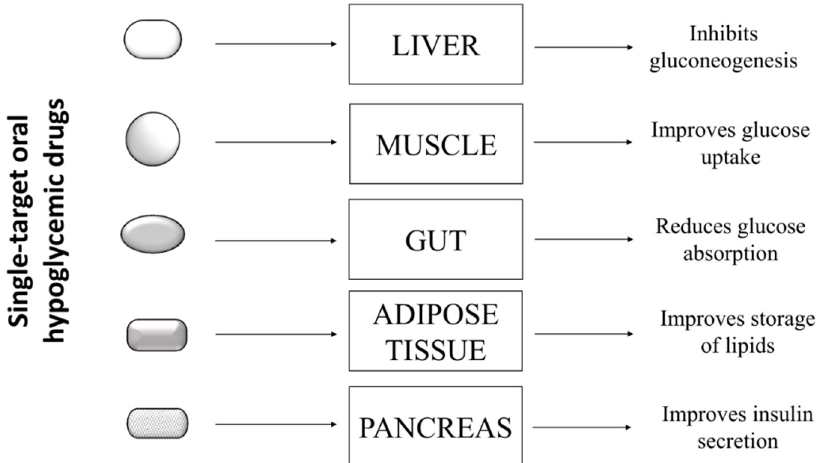
Figure 1. Antidiabetic strategy based on the mono-drug therapy: each antidiabetic drug is adminis- tered alone and works on a specific target.